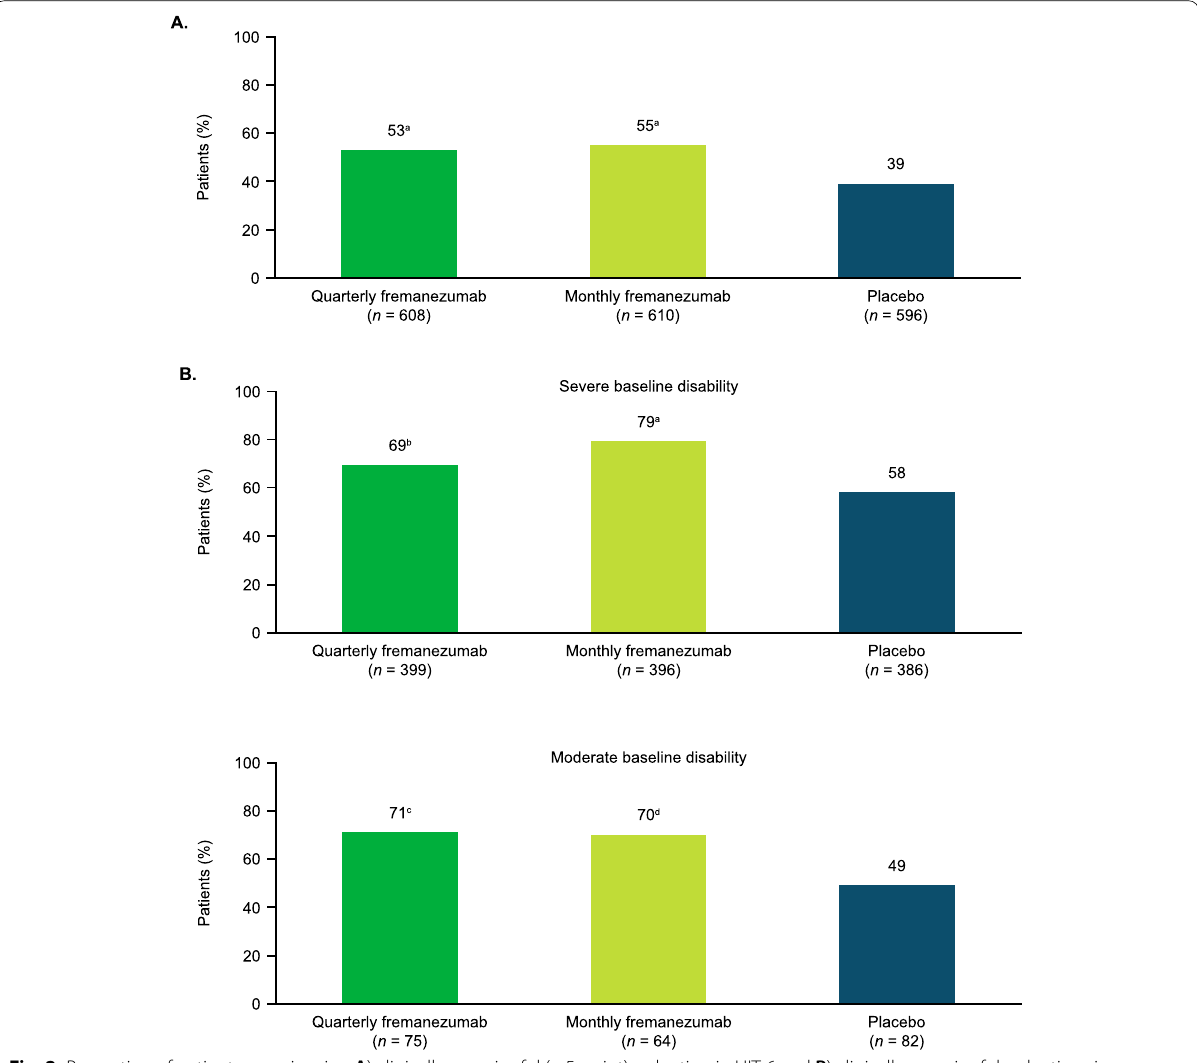
disability baseline MIDAS score, > 20; moderate baseline disability = score 30% reduction for severe disability and = ≥ available for analysis of change in HIT-6 or MIDAS scores at the end of treatment. a P < 0.0001 versus placebo. b P versus placebo. d P 0.0137 versus =